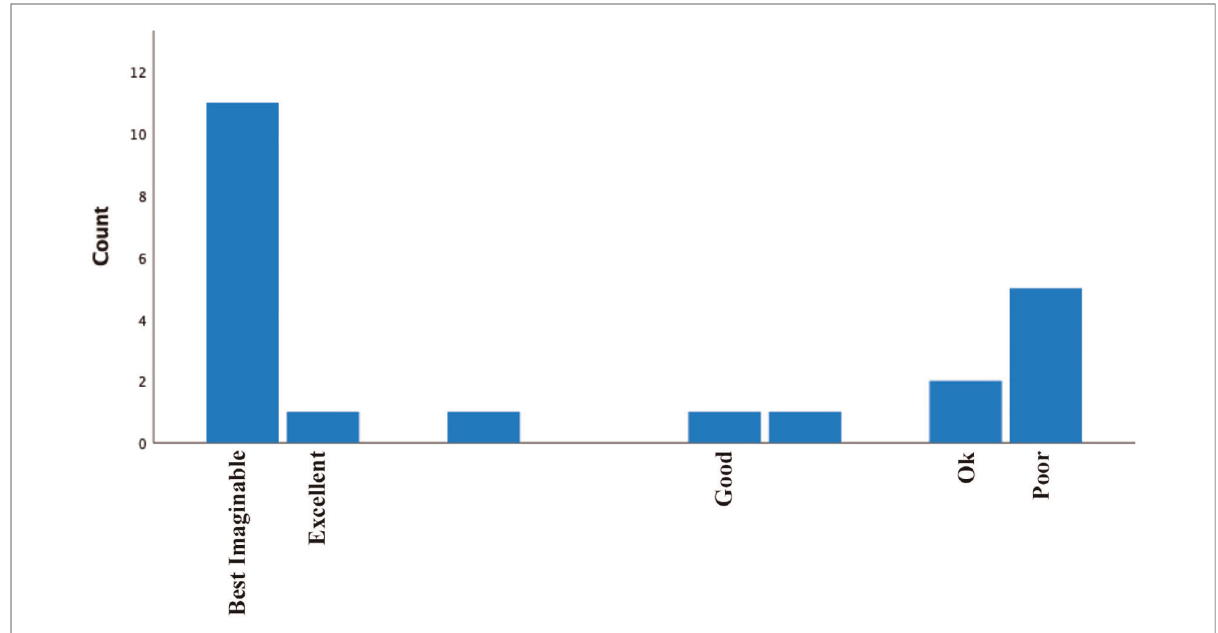
FIGURE 4 A histogram of system usability scale